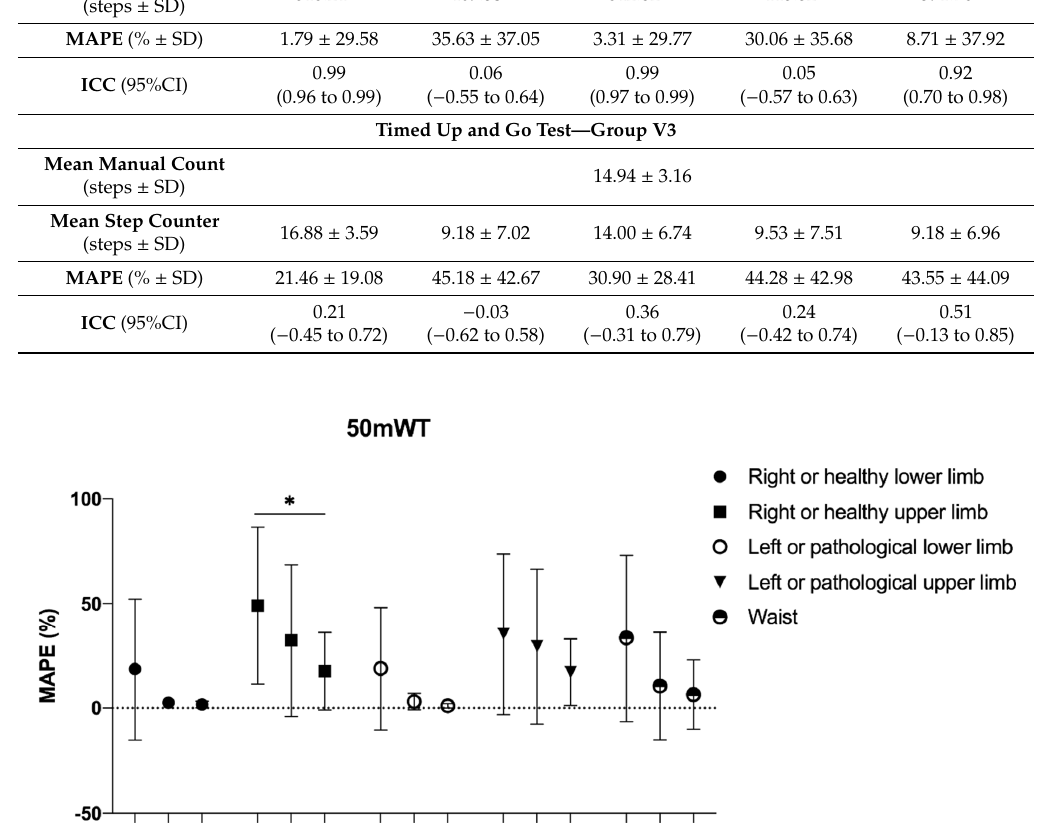
Figure 2. Comparison of the mean absolute percentage error in the 50 m walking test (50 m WT) for the healthy group ( n = 10), pathological group ( n = 43), and group V3 ( n = 17). Legend: P: pathological group; H: healthy group; *: p < 0.05.